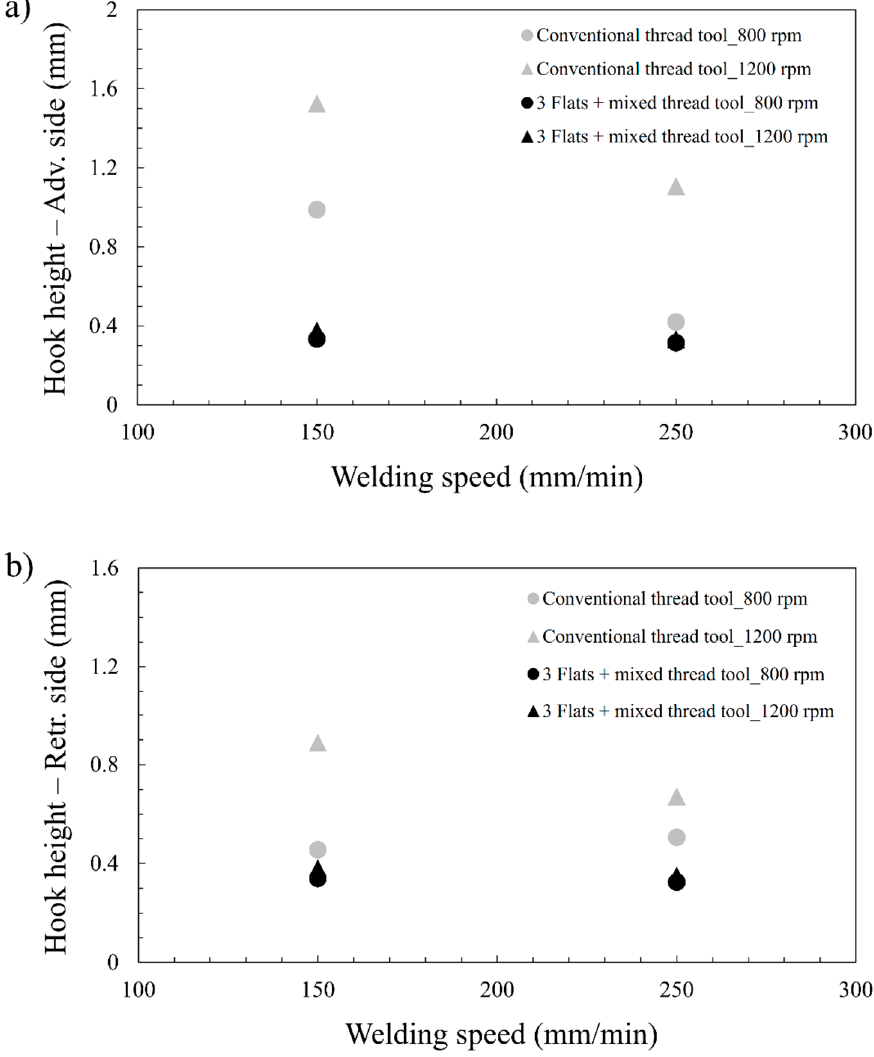
Figure 8. ( a ) Hook height at the advancing side (D1 on Figure 3b) and ( b ) hook height at the retreating side (D2 on Figure 3c) as a function of welding speed for the studied tool geometries and rotational speeds.